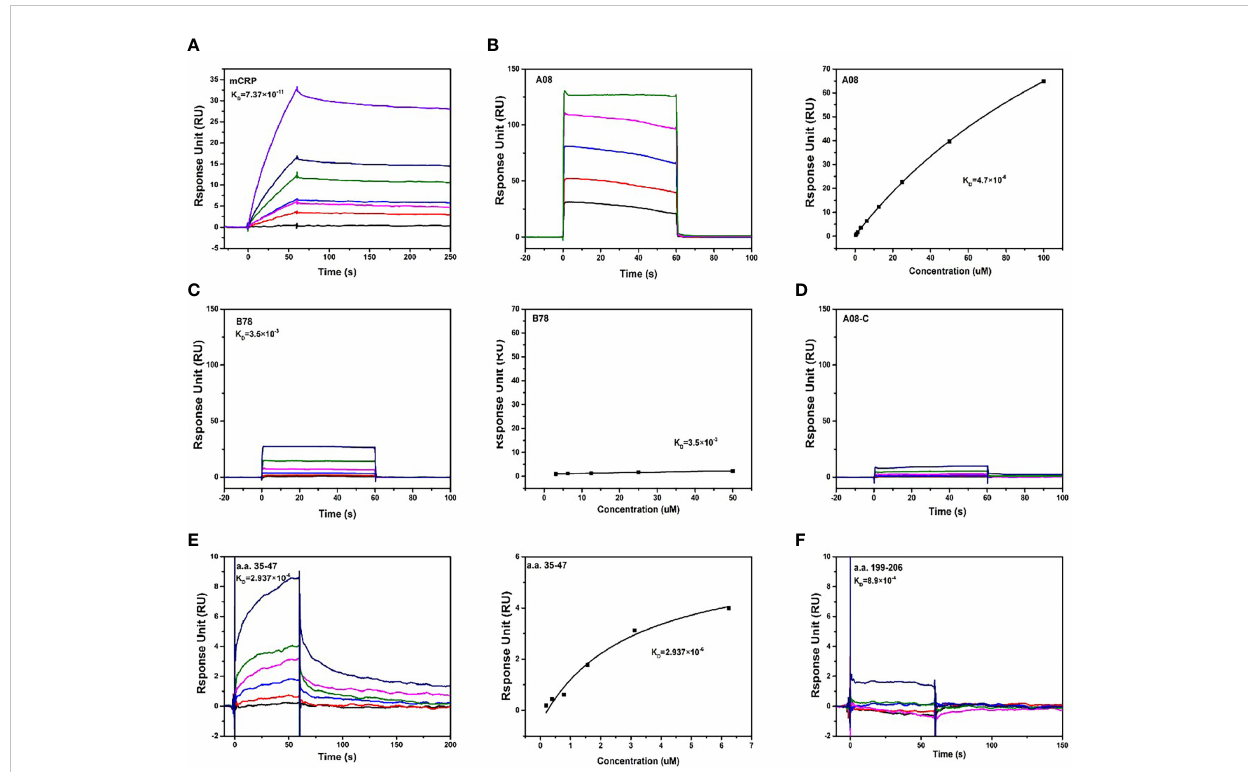
FIGURE 4 The binding epitopes of mCRP and C1q by SPR method. (A) Fix C1q on the CM5 chip and add different concentrations of mCRP, KD=0.0737 nM. (B) To clarify the key epitopes of binding, CRP was coupled to the CM5 chip, 200 s of the urea-deforming agent was injected, and CRP was depolymerized into mCRP. Recombined peptides of different concentrations A08, KD=4.7 m M. The curve was dose-dependent. (C) Based on B, change A08 to B78, KD=3.5 mM, the binding was very weak, and the steady-state curve showed that the response value changes a little as the concentration increases. (D) Similarly, different concentrations of A08-C were injected, KD=0. mCRP was hardly combined with A08-C. (E) C1q was immobilized on a CM5 chip, and different concentrations of a.a.35-47 were injected, which was characterized by slow binding and fast dissociation. The steady-state curve was used to determine the binding to dose-dependent, KD=2.937 m M. (F) C1q was fi xed on the CM5 chip and different concentrations of a.a.199-206, KD=0.89 mM was injected. Therefore, C1q mainly bound to a.a.35-47 of mCRP, and mCRP mainly bound to the A08 epitope of C1q.